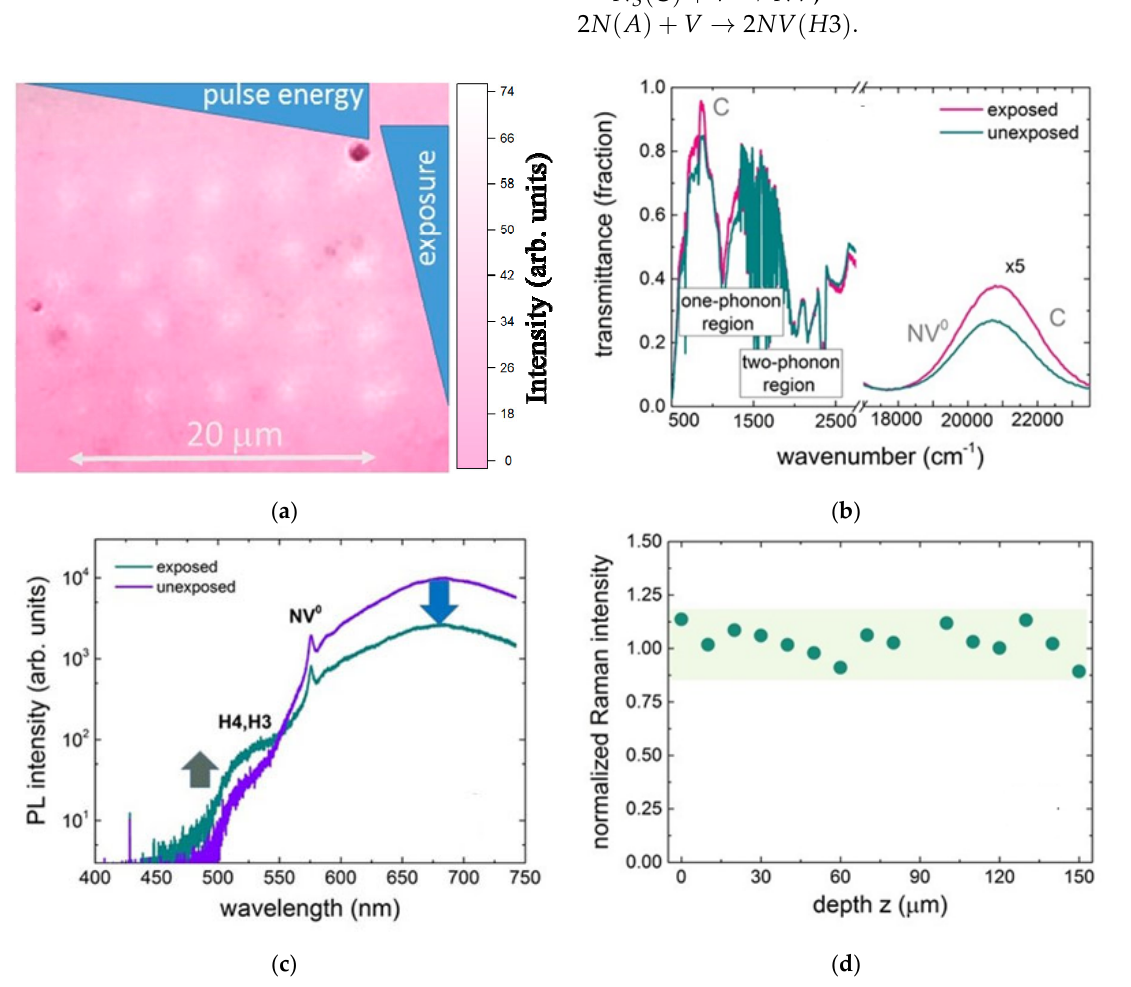
Figure 10. ( a ) Array of bleached micromarks in Ib HPHT diamond inscribed by 515 nm and 0.3 ps laser pulses at 0.25 NA focusing, variable energies (0.2–1.6 μ J) and exposures of 60, 120, 180, and 240 s (×100 kHz); ( b ) FT ‐ IR and optical transmission spectra of the bleached (1.6 μ J, 240 s) and unexposed (reference) regions inside the diamond; ( c ) PL spectra of the bleached (1.6 μ J, 240 s) and unexposed (reference) regions inside the diamond; ( d ) normalized (exposed/unexposed) 428 nm Raman line intensity versus depth inside the diamond, showing no distinct damage to the carbon lattice in the bleached regions. Adapted from